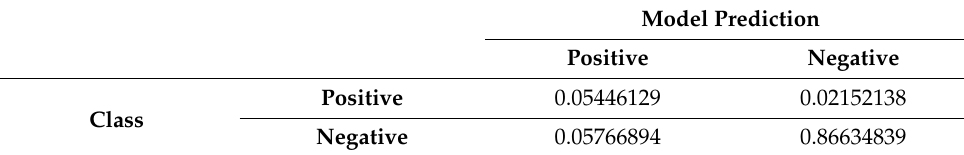
Table 5. Confusion matrix (Improved U-Net #1/ small number of particles).